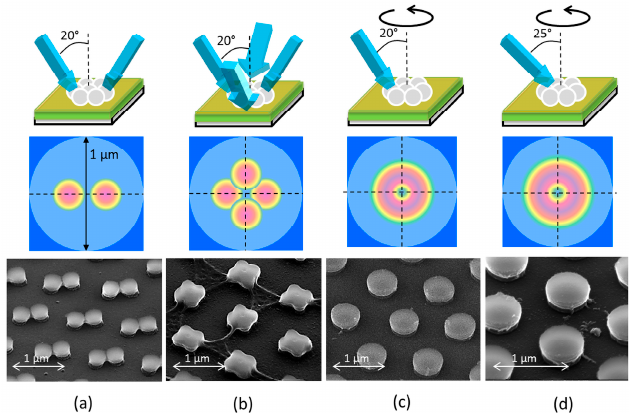
Figure 3. Illustration of the illumination conditions (top row), top view the expected nanojet arrangement in the TiO 2 layer (middle row, red indicates increased intensity) and SEM photographs of the resulting TiO 2 pattern (bottom row) of hexagonally periodic structures on BK7. ( a ) two opposite exposures of angle 20° leading to a bow-tie structure, ( b ) four exposures of angle 20° leading to clover leaf structure, ( c ) one exposure under an angle of 20° with substrate rotation leading to nanopillars of 500 nm diameter and ( d ) one exposure under an angle of 25 ◦ with substrate rotation leading to nanopillars of 600 nm